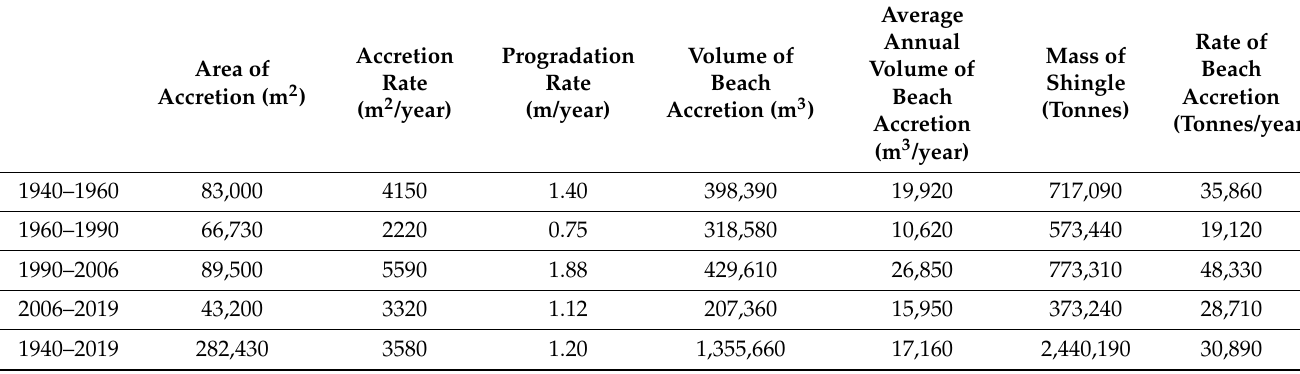
Table 3. Calculations of the area of accretion from Google Earth Pro™, annual rates of accretion, progadation rate, shingle beach volume, average annual volume of beach accretion, mass of shingle, and rates of beach accretion. Values have been rounded up and down to the nearest 10